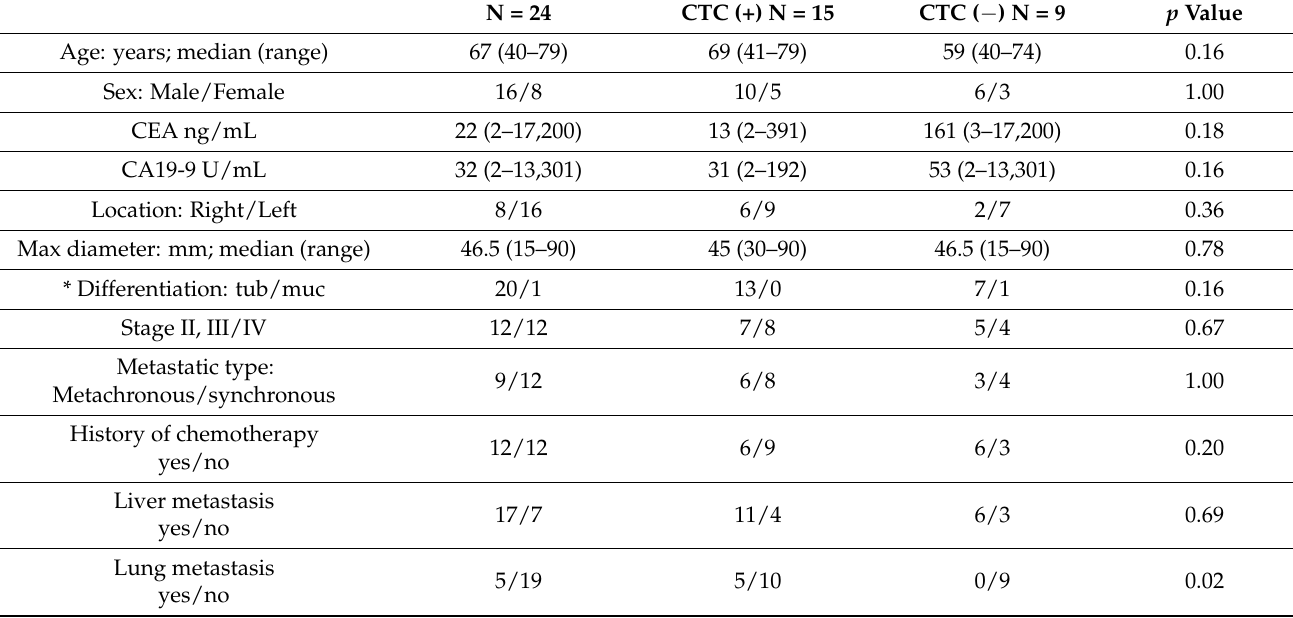
Table 4. Relationship between CTC and clinicopathological